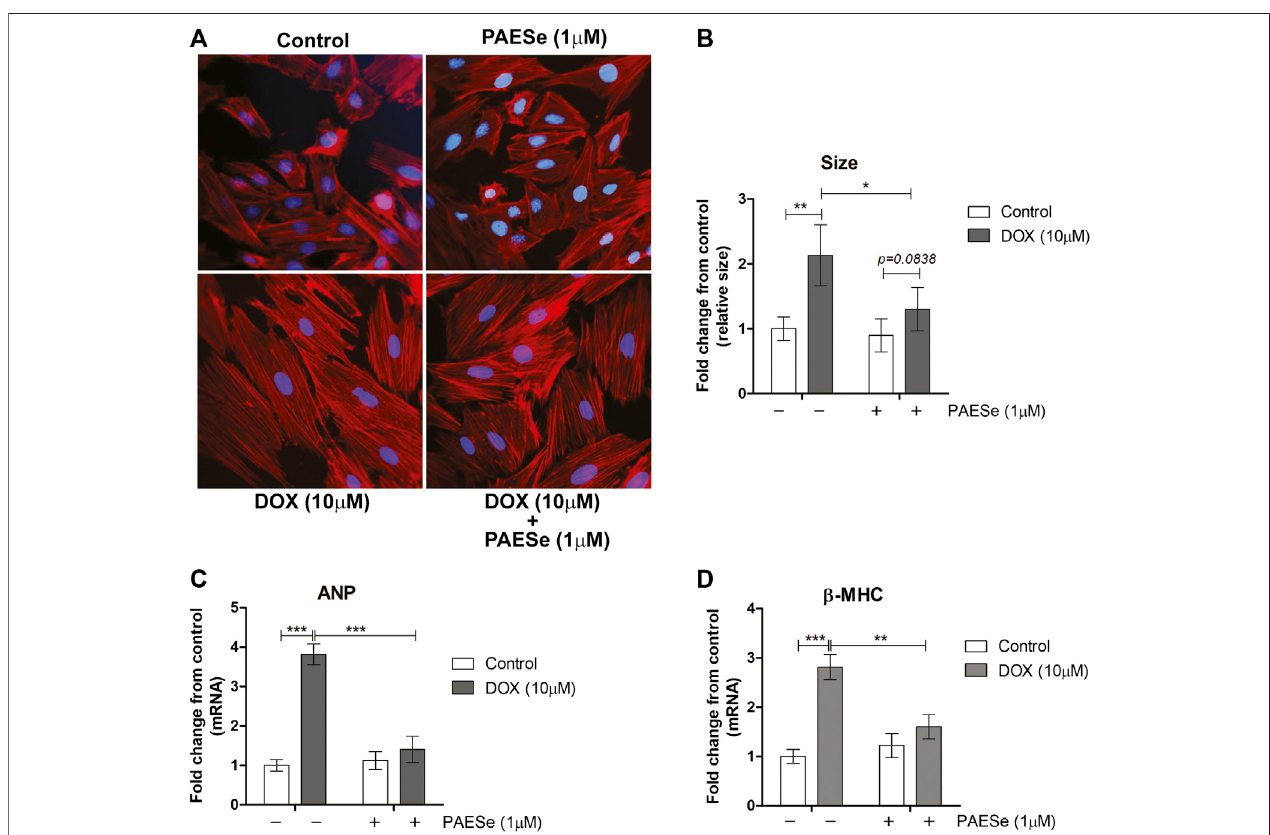
FIGURE 2 | PAESe protects against DOX-induced cardiac hypertrophy in H9C2 cardiomyoblasts. (A) Representative phalloidin fl uorescence imaging displays protective effects by PAESe (1 µM) against DOX (10 µM) mediated hypertrophy in H9C2 cell as demonstrated by fold change in size by treatment. (B) Graphical measurement of morphometric measurements from panel A . ( C , D ) ANP and β -MHC mRNA expression were evaluated by two-step qPCR analysis from cells treated with DOX (10 µM) with and without PAESe (1 µM) for 24 h. Data are represented as fold change from control and in the case for qPCR analysis standardized to β -actin. Indicated above are the mean ± S.E.M. of the replicates, N (cid:2) 4 individual experiments, **; p < 0.001, ***; p < 0.0001, ###; p <